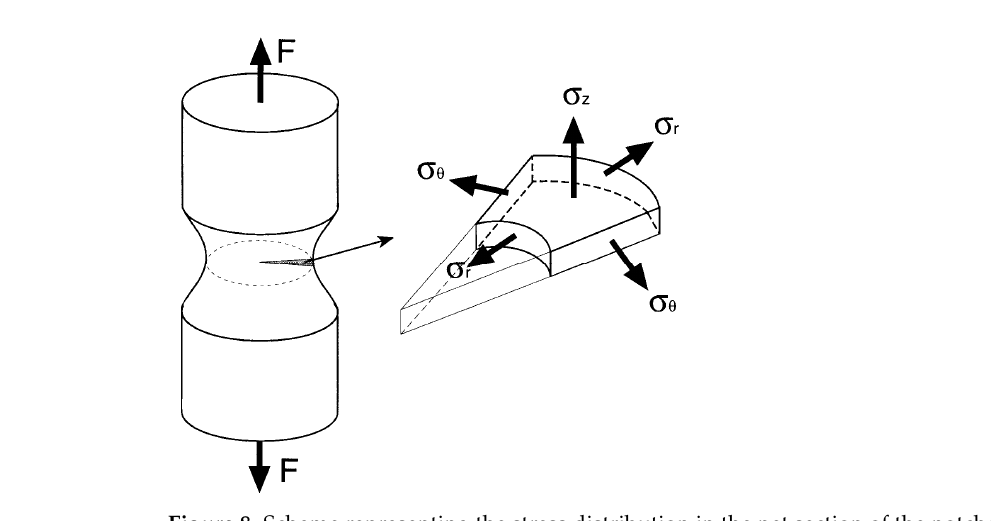
Figure 8. Scheme representing the stress distribution in the net section of the notched wires.